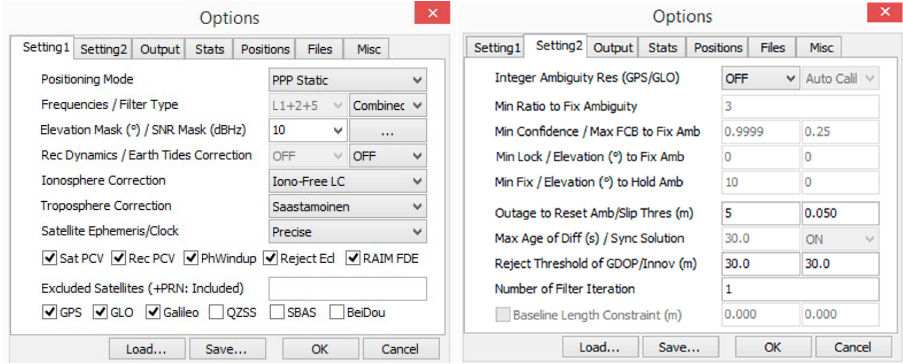
Figure 6. Output options interface with the RTKPOST module.